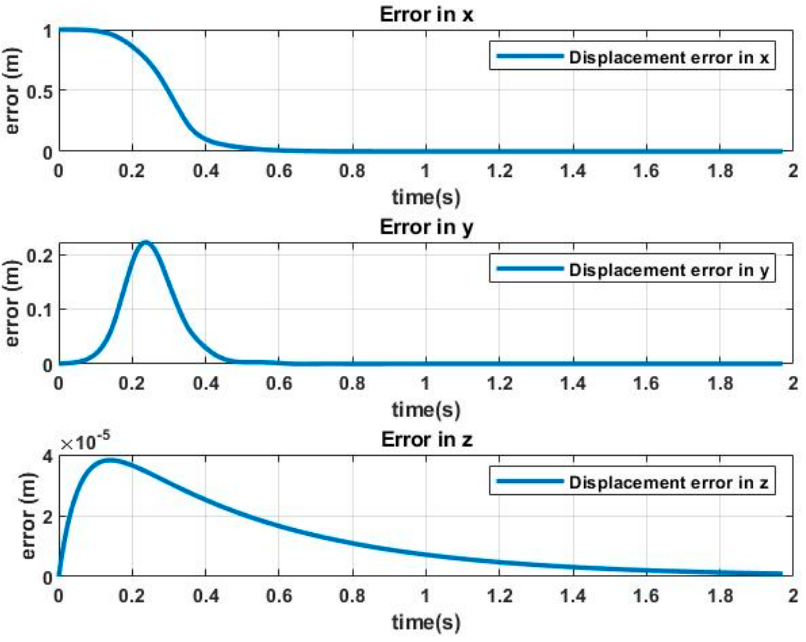
Figure 12. Relative displacement errors vs. time from task 1.